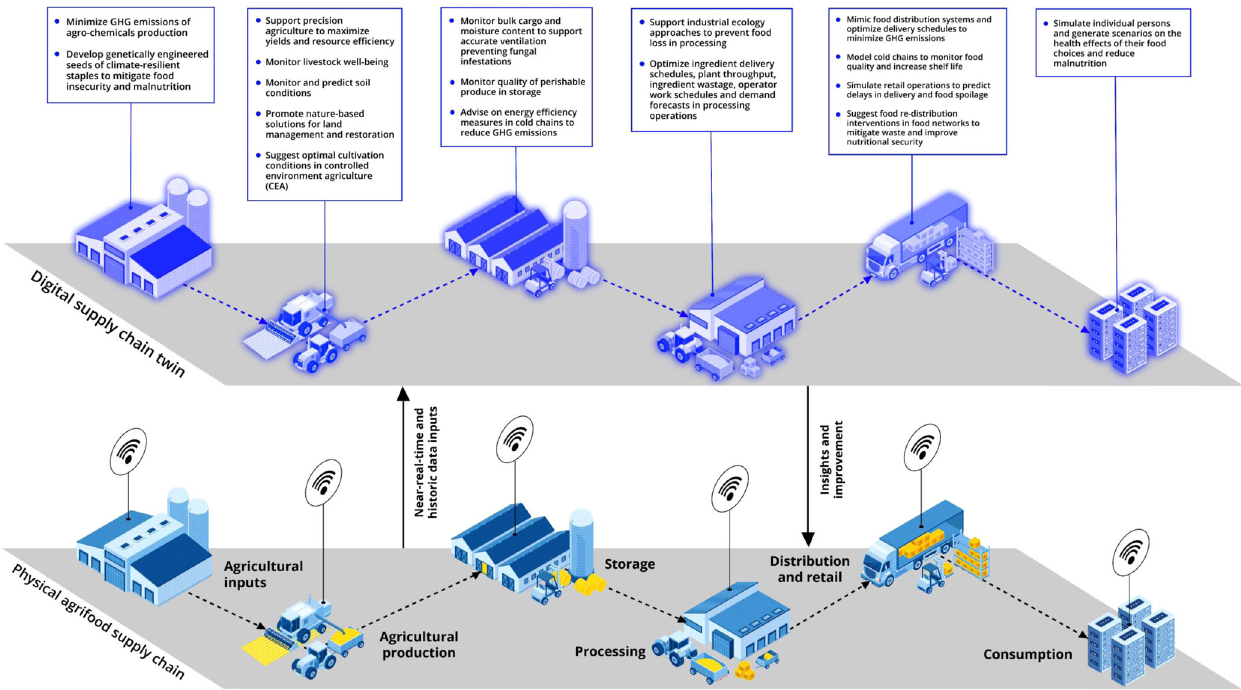
Fig. 1 Example of apparent bene fi ts of digital twins in the agrifood supply chain. This diagram indicates potential or possible 17 bene fi ts of digital twins in reducing greenhouse gas emissions, food waste and malnutrition, spanning six steps of a typical agrifood supply chain, as presented and discussed in this